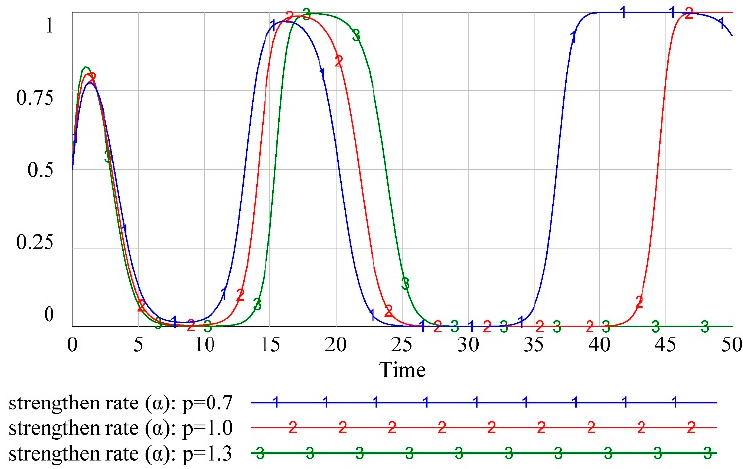
Figure 6. Effect of different penalty factors on defender in static penalty scheme.